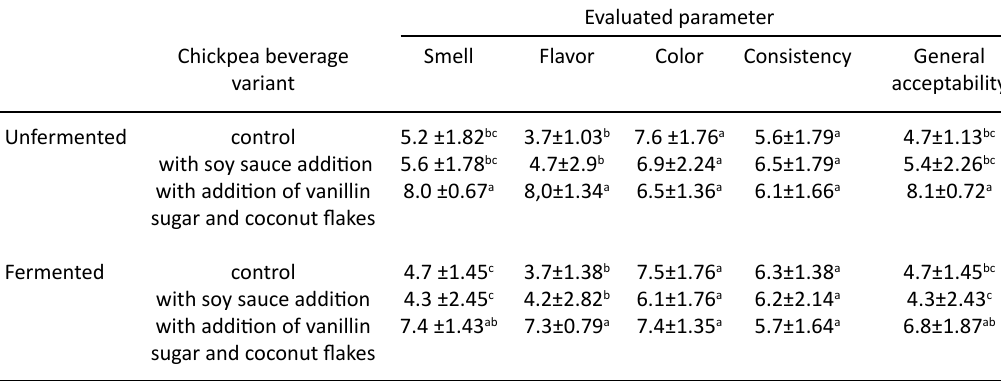
Table 2. Results of the preliminary sensory assessment of the chickpea